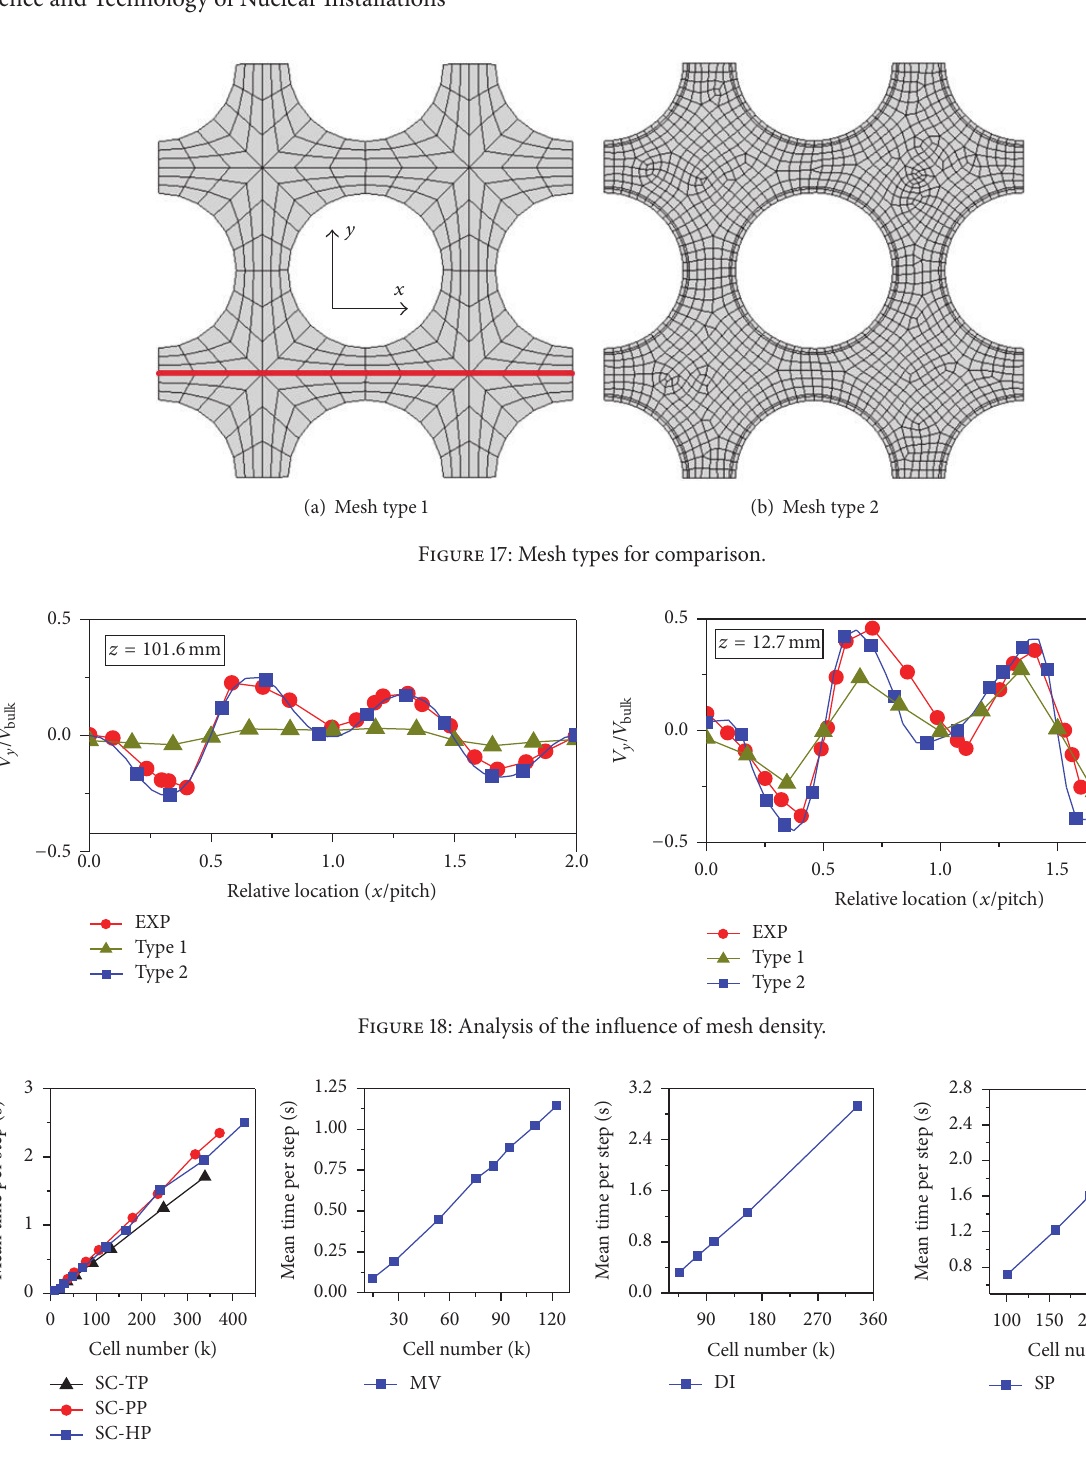
Figure 19: Regularity for the mean time per iteration